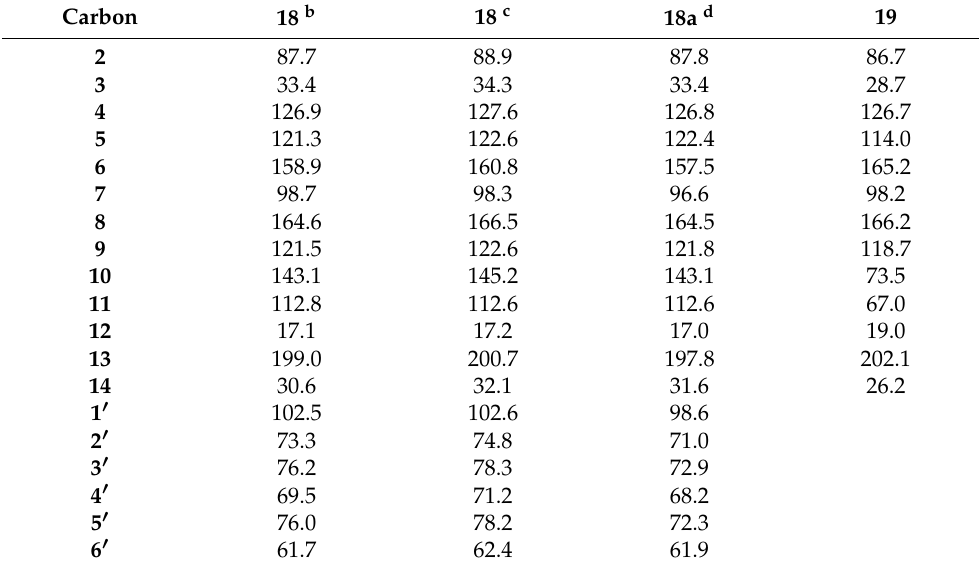
Table 3. 13 C NMR data of compounds 18 , 18a and 19